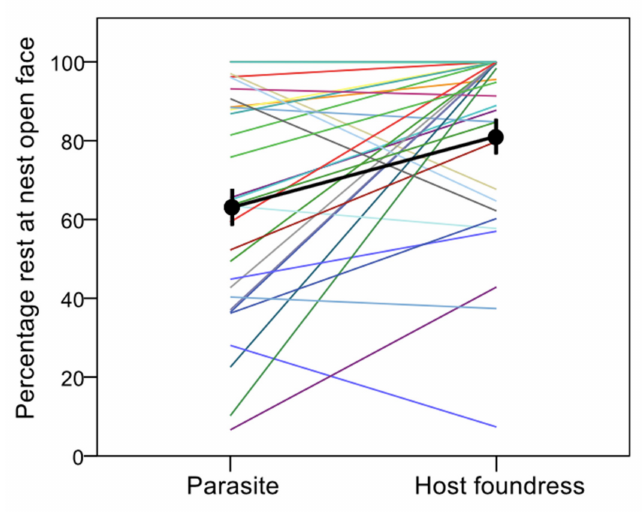
Figure 4. Percentage of time parasites and hosts spent resting at the front face of the nest. Each line links the values for the parasite (left) and her host foundress (right) living at the same colony (pairwise data); the black thick line links the mean values ( ± s.e.) for parasites and foundresses (after averaging by colony).